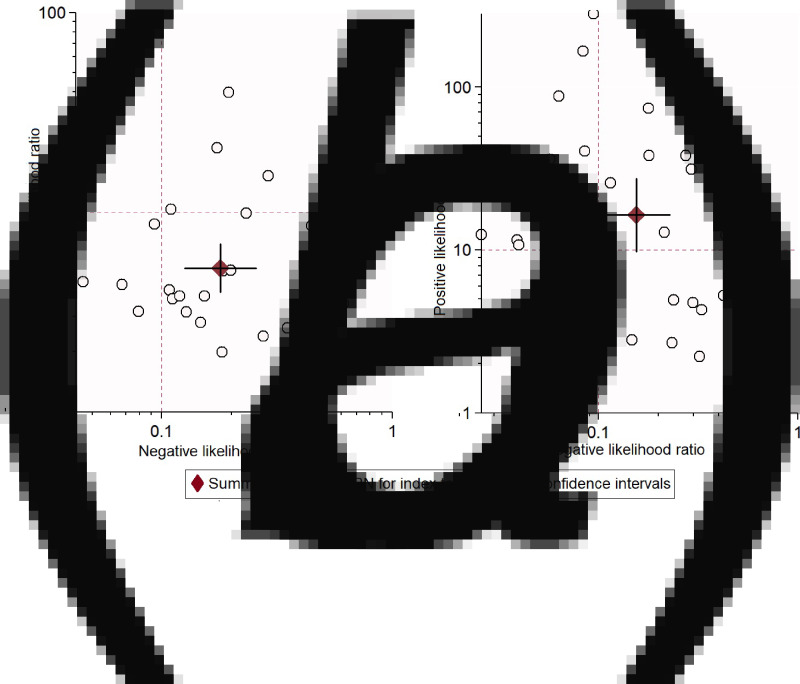
Likelihood scatter grams. (a) For semi-quantitative methods, (b) for quantitative methods. LUQ: exclusion and confirmation, LRP >10, LRN <0.1; RUQ: confirmation only, LRP >10, LRN <0.1; LLQ: exclusion only, LRP <10, LRN <0.1; RLQ: no exclusion or confirmation, LRP <10, LRN >0.1.